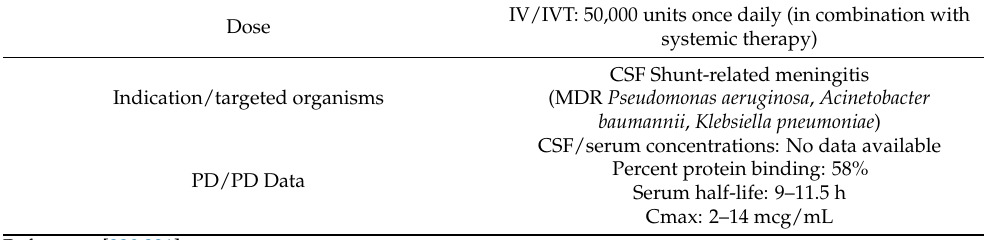
Table 9. Polymyxin B dosing and PK/PD data. Dose Indication/targeted organisms